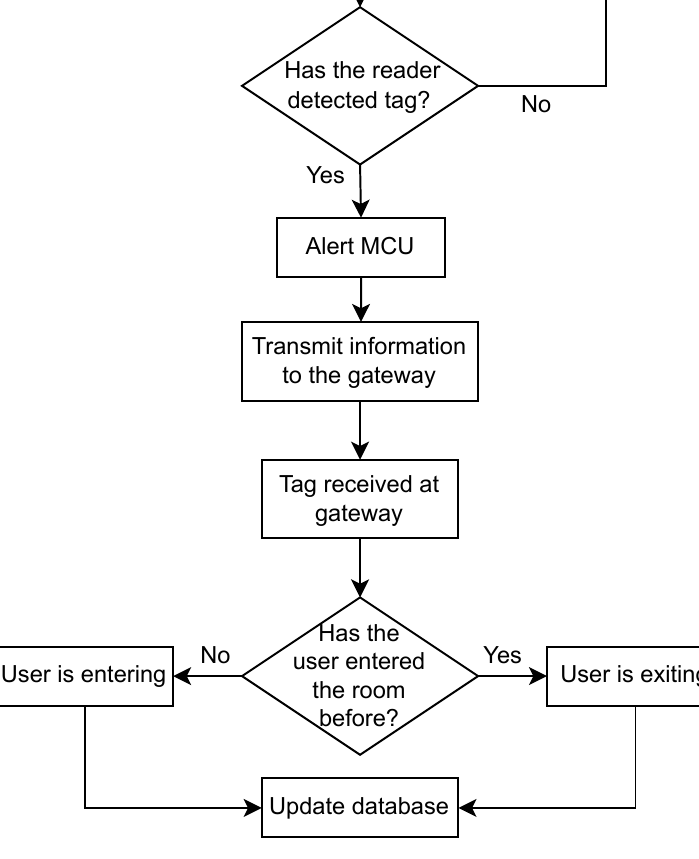
Figure 13. RFID algorithm 2 software